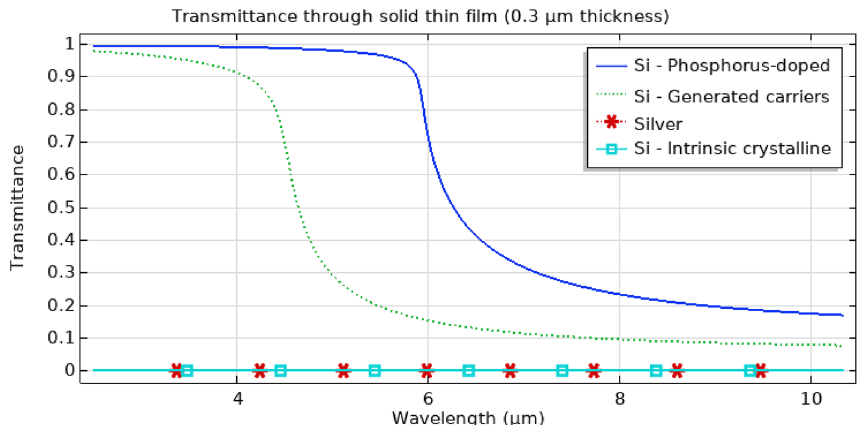
Figure 3. Transmittance as an indication of the opacity of a solid thin film with a thickness of 0.3 µm for Silver, intrinsic crystalline silicon, silicon with 10 20 cm −3 phosphorus doping, and 10 20 cm −3 generated excess carrier concentration. While silver and intrinsic Si show zero transparency, silicon, with generated excess carriers as well as doped Si, show high transparency up to 4 µm and 6 µm